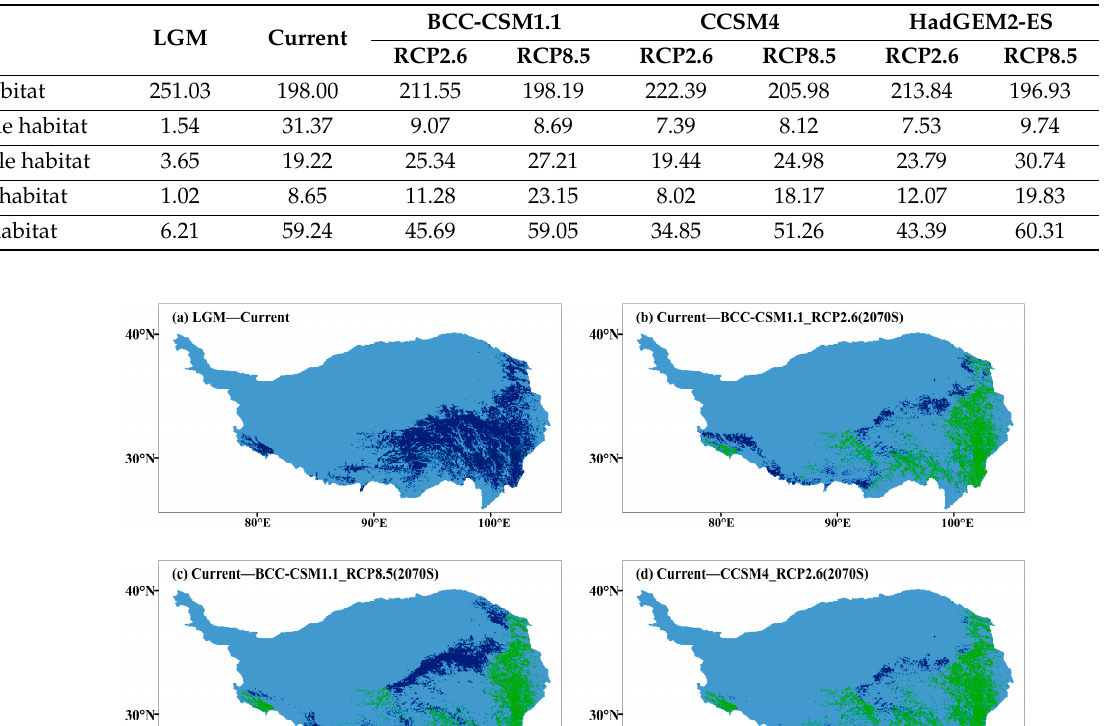
Table 4. Area of suitable habitat of J. tibetica in different periods ( × 10 4 km 2 ).